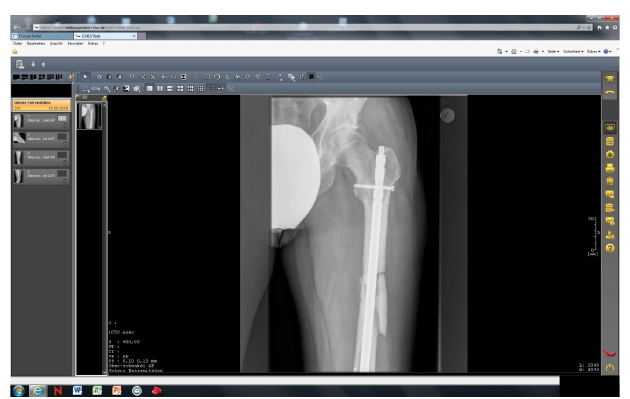
Figure 2. Teleradiological transmission via TKmed®.